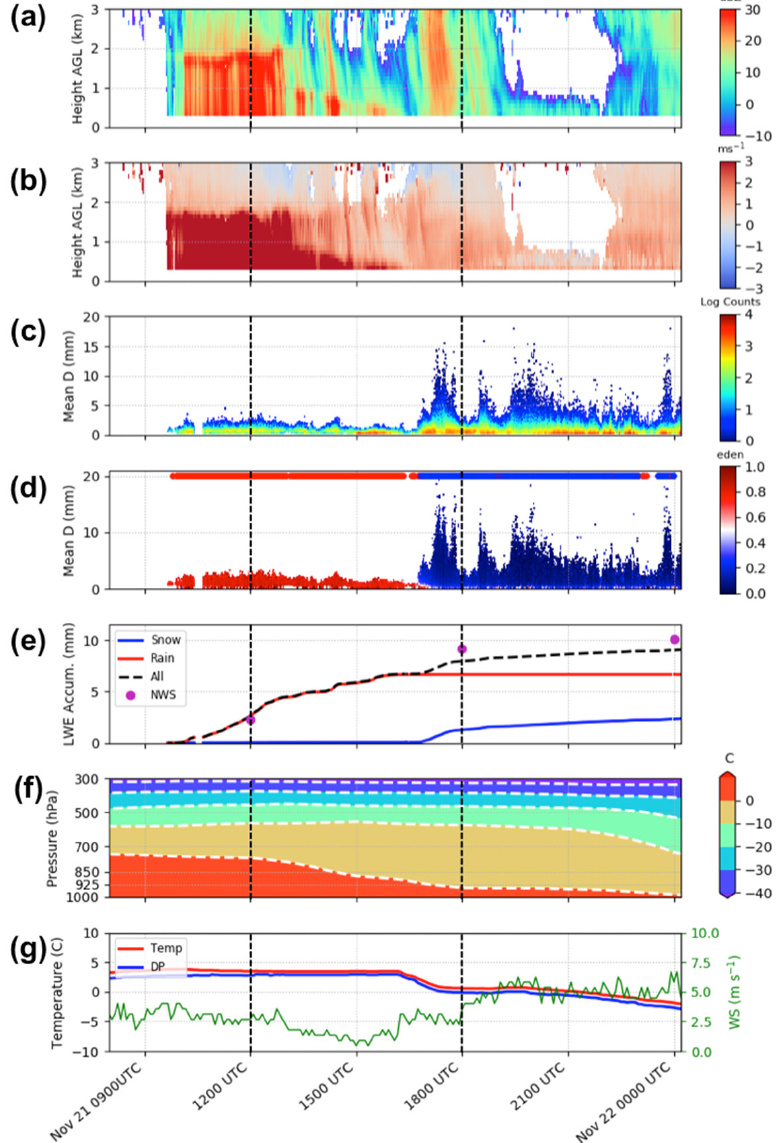
Figure 5. Observations during the 21 to 22 November 2019 event rain-to-snow transition event. Shown are MRR reflectivity ( a ) and Doppler velocity ( b ), PIP PSDs ( c ) and density estimates ( d ), Parsivel hydrometeor identification ( d , red and blue dots on the upper portion of the panel), PIP and NWS LWE accumulation ( e ), ERA temperature profiles (red > 0 °C) ( f ), and surface temperature, dew point, and winds ( g ). The dashed lines indicate time periods examined in the next figure.